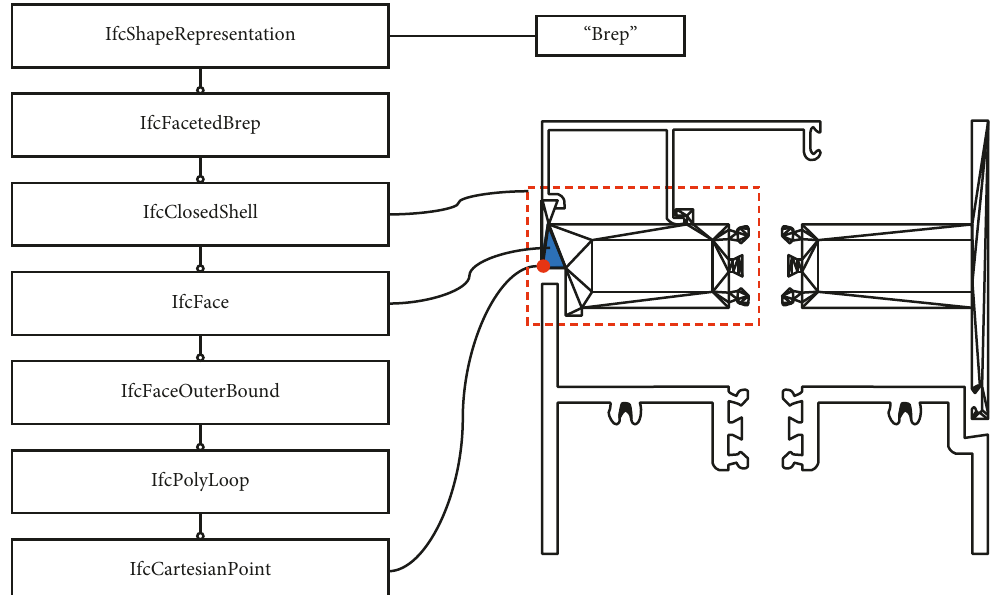
Figure 2: Data structure of “Body Brep Geometry” in IFC.